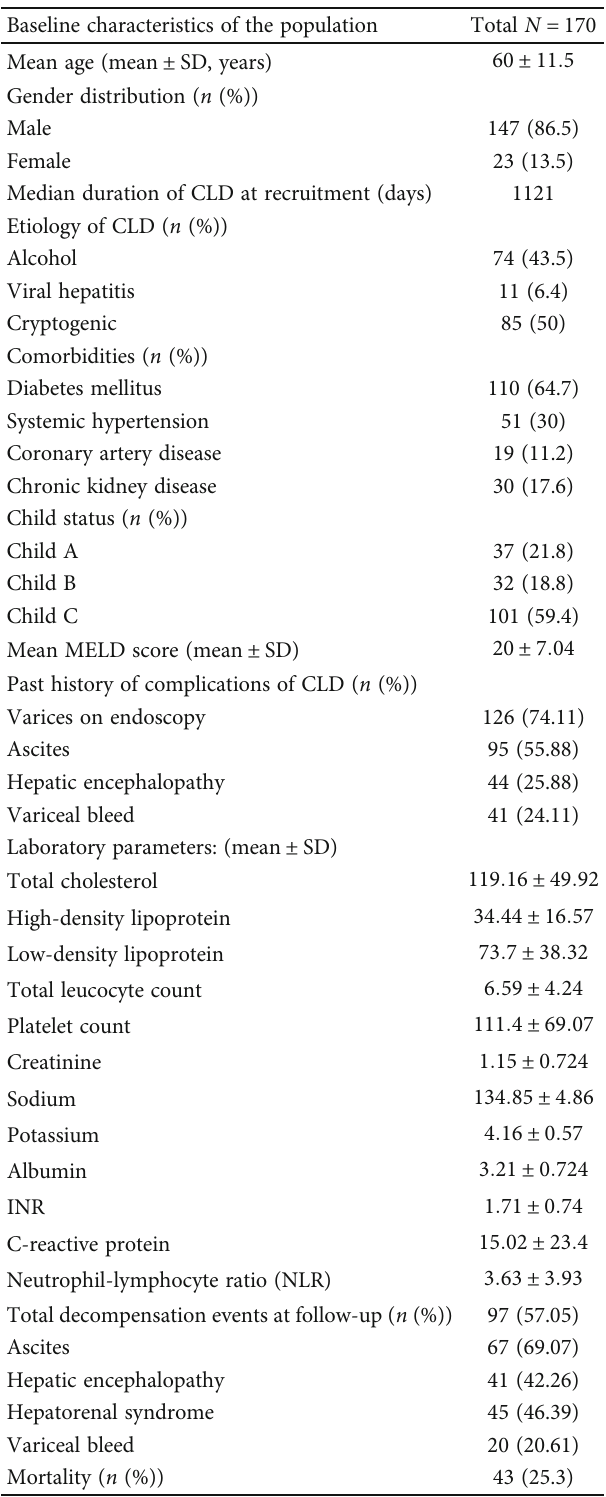
Table 1: Distribution of variables among patients with decompensation events on follow-up as compared to patients with